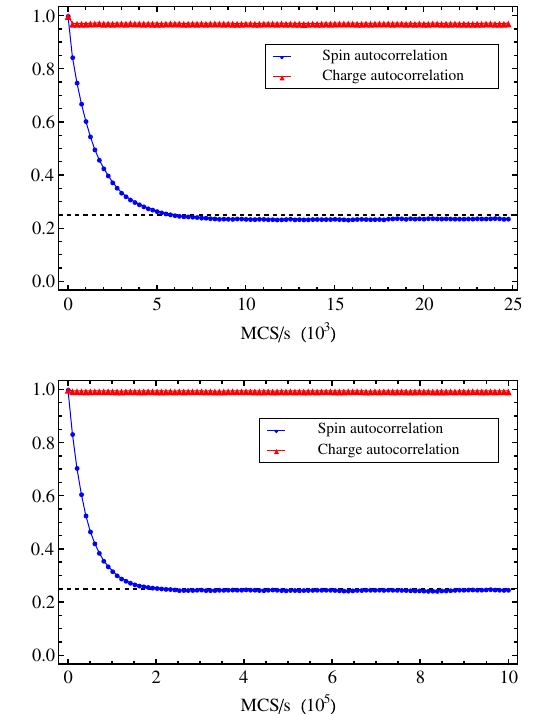
FIG. 5. Charge- and spin-autocorrelation functions for (cid:2) (cid:4) ¼ 0 : 57 (top) and (cid:2) (cid:4) ¼ 0 : 41 (bottom) for T (cid:4) ¼ 0 : 20 . The dotted line in each plot indicates the asymptote at C s ð t ¼ 1Þ ¼ 1 = 4 . The time required for the autocorrelation function to reach its longtime asymptote is significantly greater at (cid:2) (cid:4) ¼ 0 : 41 than at (cid:2) (cid:4) ¼ 0 : 57 . This behavior is indicative of a slowing of the dynam- ics as the monopole density increases. As (cid:2) (cid:4) increases, n de- creases [see Fig. 2(b)] and the t ¼ 1 asymptote of C s ð t Þ is slightly reduced relative to the value for the ideal monopole crystal. We note that both panels correspond to points far into region